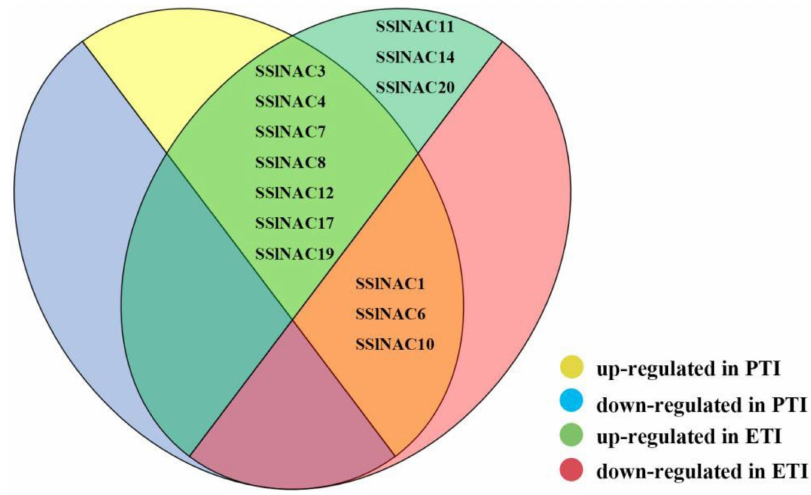
Figure 6. Venn diagram showing the expression patterns of the 20 SSlNAC genes during PTI and ETI under Pst DC3000